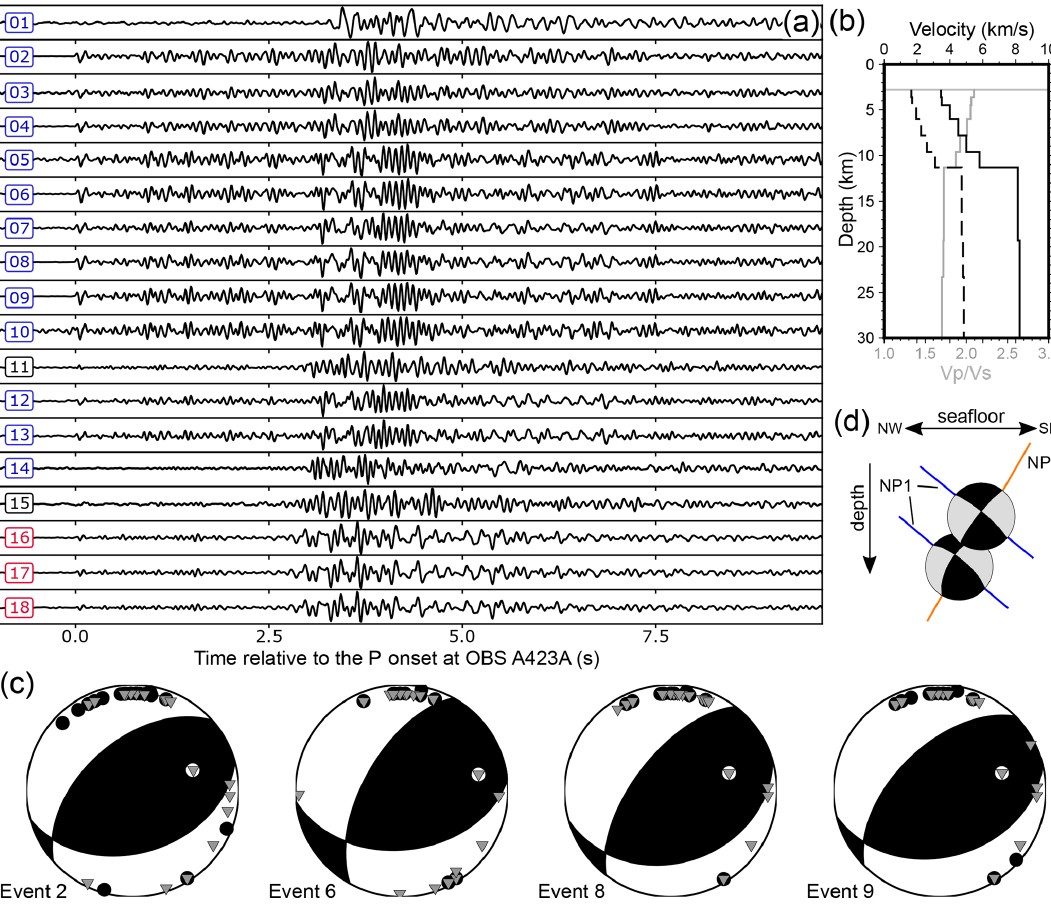
Figure 4. (a) All observed cluster events recorded at station A423A, Z component (bandpass filtered 2–20Hz). The P onsets are shifted so that they align at 0s. (b) 1-D velocity models (Vp, solid line, Vs, dashed line, and Vp / Vs grey solid line) used to relocate the cluster events. (c) Focal mechanisms of events 2, 6, 8 and 9, computed using the amplitude ratio of Sv /P (grey inverted triangles) and the wave polarisation (black dots for negative polarisation) determined at OBS and land stations. (d) Sketch of the two nodal planes (NP) of events 2 (upper) and 6 (lower) as side